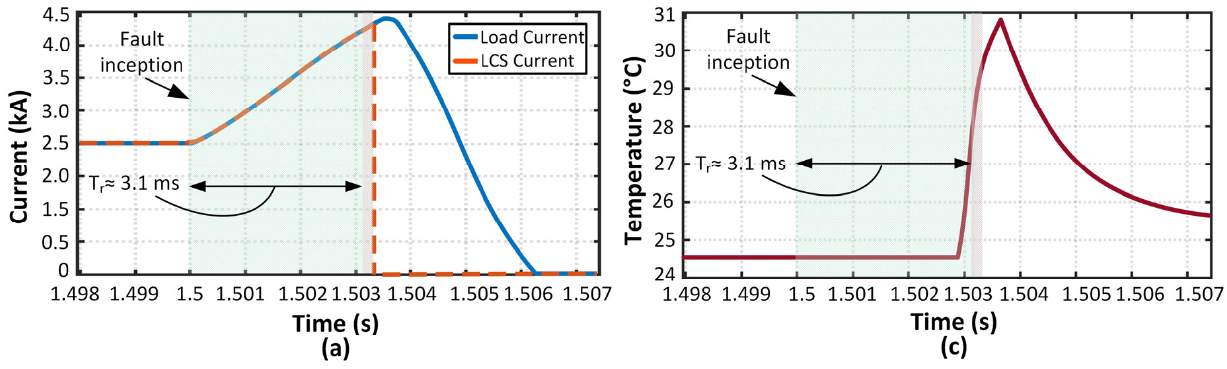
Figure 15. Fault current interruption under 3 ms time window ( a ) DC fault current, ( b ) Line and DCCB voltage, ( c ) IGBT valve temperature, ( d ) MOSA energy absorption, ( e ) Breaker Status. 7. Comparison with Existing Methods Compared to existing neural network-based protection algorithms [23,27,38], the proposed algorithm is more comprehensive and efficient. The use of direct faulty samples is further illustrated in [27], where a high workload is used to detect faults. It uses 13 ANN units for fault rectification. In [38], trip commands took around 4 ms, and the cases studied were not comprehensive. There was only an analysis of noise endurance up to 50 dB, whereas we studied fault cases up to 20 dB. In [39], a low number of fault cases were investigated, and noise endurance was not verified. Moreover, direct fault samples were integrated, which added extra computational burden. In [23], the fault recognition rate is low at high fault resistances (i.e., 84.5%) with no backup protection. The authors of [23] propose the use of another backup protection to cover main relay failures. However, the proposed strategy operates accurately even in high-fault resistance conditions (i.e., 96.30%), and multiple segments be used to cover failures. Unlike [21,26], the proposed algorithm configures the ANN structure autonomously and does not require any new infrastructure or communication links. The proposed MMC-MTDC protection system is now more reliable and robust, overcoming the short- comings of other solutions.